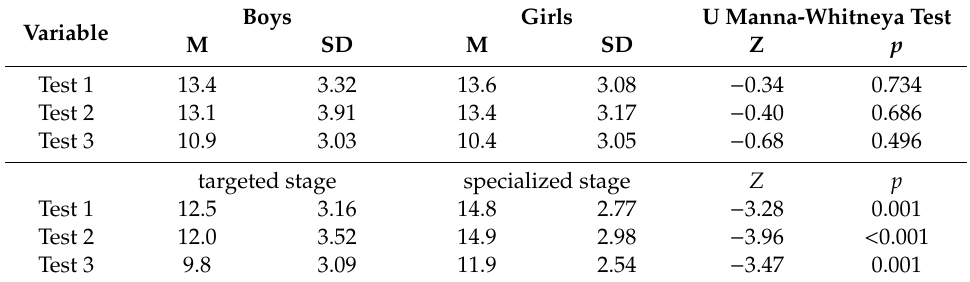
Table 3. ResultsoftheTableTennisSpecificBatteryTest(TTSBT):comparisonbygenderandtrainingstages.